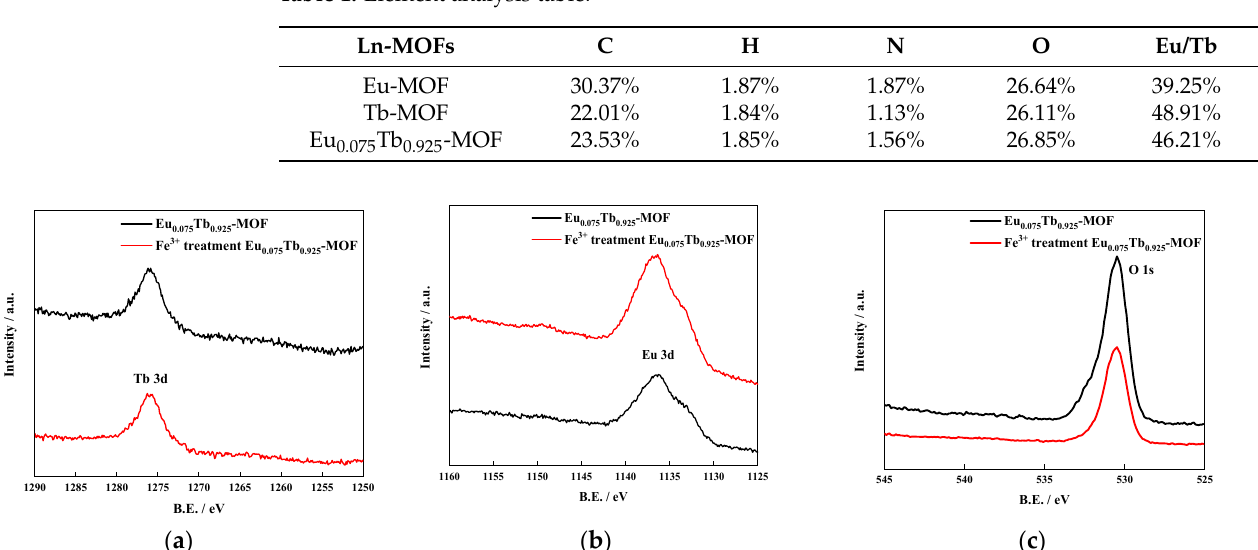
Figure 4. XPS of Eu 0.075 Tb 0.925 -MOF before and after Fe 3+ addition: ( a ) Tb 3d, ( b ) Eu 3d, and ( c ) O 1s.